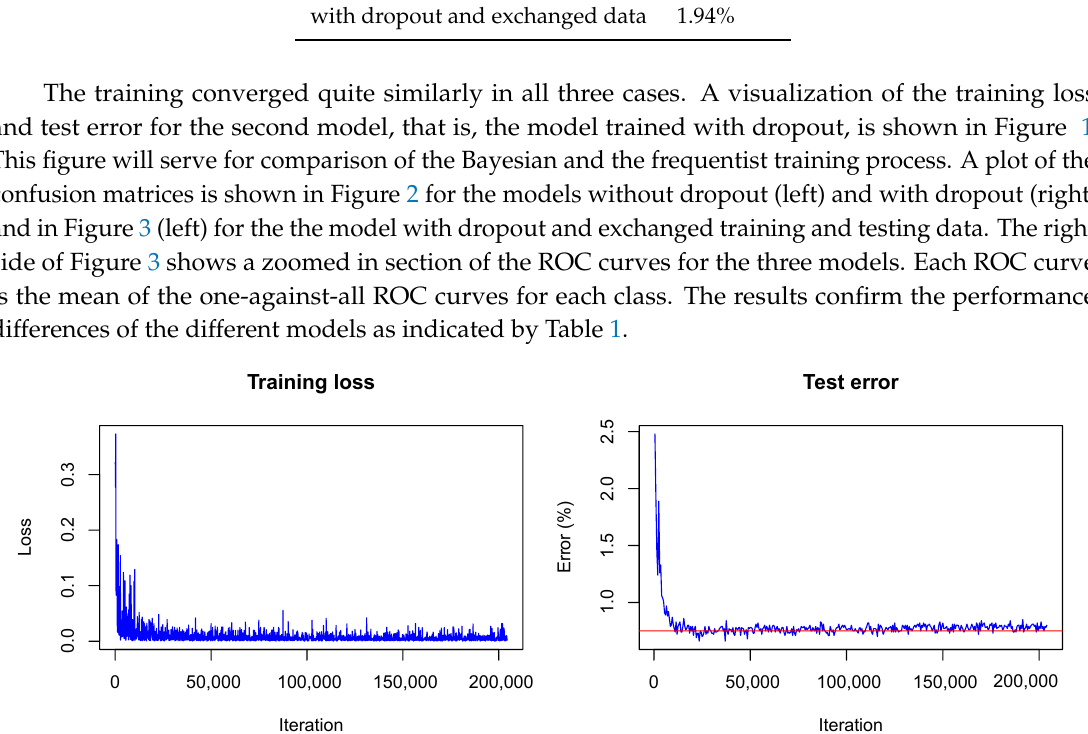
Figure 1. Training visualization of frequentist LeNet with dropout. The horizontal line marks the achieved accuracy.